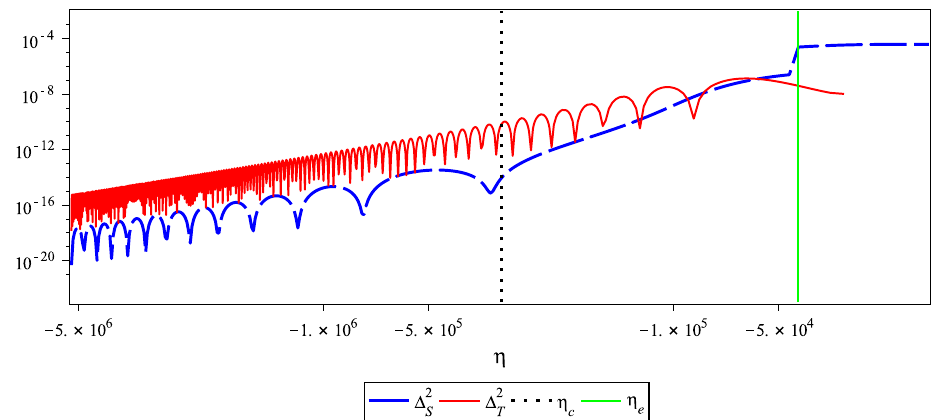
perturbation evolution. Dot black line indicates the crossing time and vertical solid green line is referred to the equality time